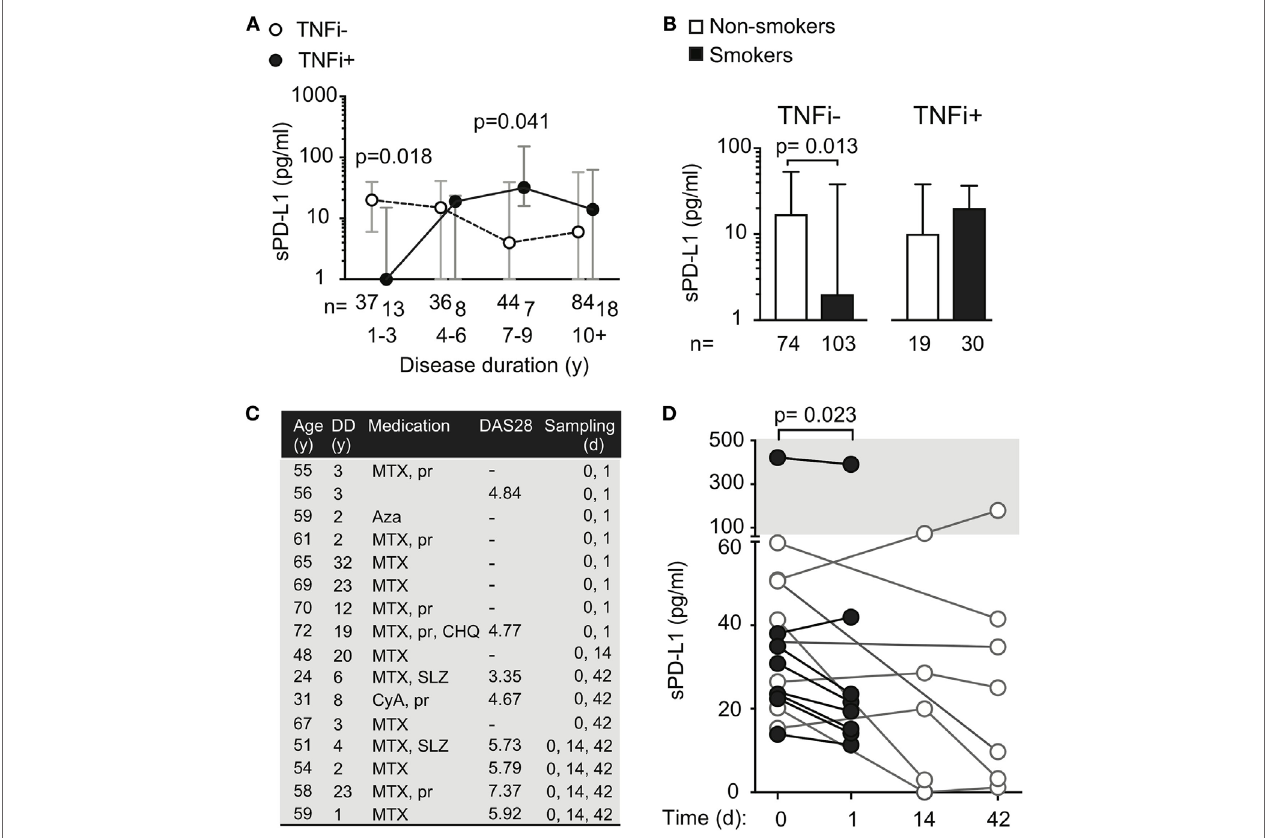
FigUre 3 | Treatment with tumor necrosis factor α inhibiting antibody (TNFi) influences serum levels of soluble PD-L1. (a) Soluble PD-L1 (sPD-L1) in serum of RA patients treated and not treated with TNFi, stratified by disease duration. Dots represent the median and whiskers represent the interquartile range. (B) sPD-L1 in RA patients who are smokers or non-smokers, stratified by TNFi treatment. The Mann–Whitney U test was applied. (c,D) sPD-L1 in RA patients before, after 1 day, 2 weeks, and 6 weeks of the first infliximab infusion of infliximab. Clinical parameters are described in (c) . The Wilcoxon matched-pairs signed rank test was applied. (c) Patient information. Abbreviations: MTX, methotrexate; pr, prednisolone; Aza, azathioprine; CHO, chlorokinolone; SLZ, sulfasalazine; CyA, cyclosporine